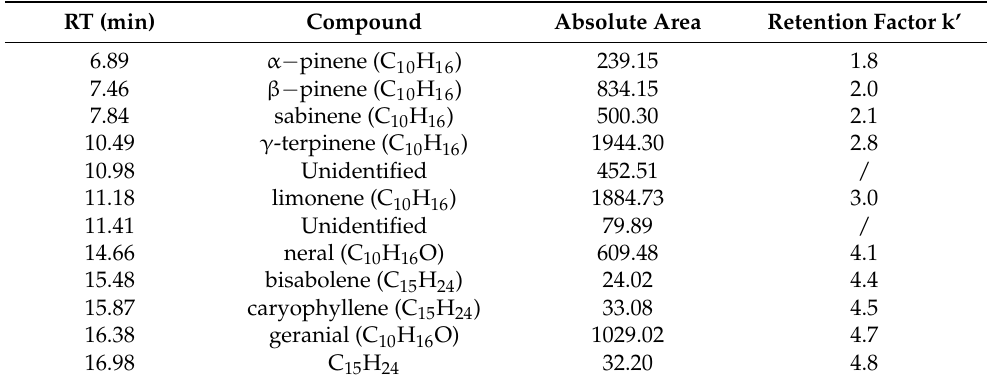
Table 2. Chemical compositions (area %) of lemon essential oil using SFC-UV data. Two columns in series were used for chromatography, i.e., a Hypercarb ® (150 mm × 4.6 mm × 5 µ m, Thermo Scientific, Waltham, Massachusetts, USA) and a Poly-(butylene terephthalate) DCpack PBT (150 mm × 4.6 mm × 5 µ m, DAICEL Corporation, Osaka, Japan). UV Detection was performed at a fixed wavelength of 220